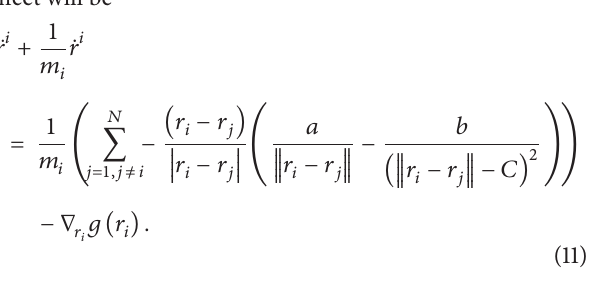
Figure 2: Two-dimensional simulation of (11) for three particles, = 2 , 𝑎 = 10 , 𝑏 = 100 , and ∇ 𝑚 𝑖